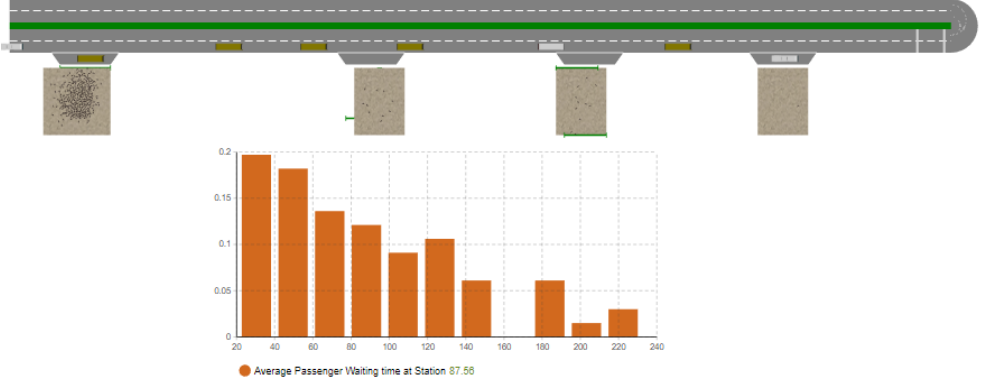
Figure 7. 3D view of BRTS simulation with graph for waiting